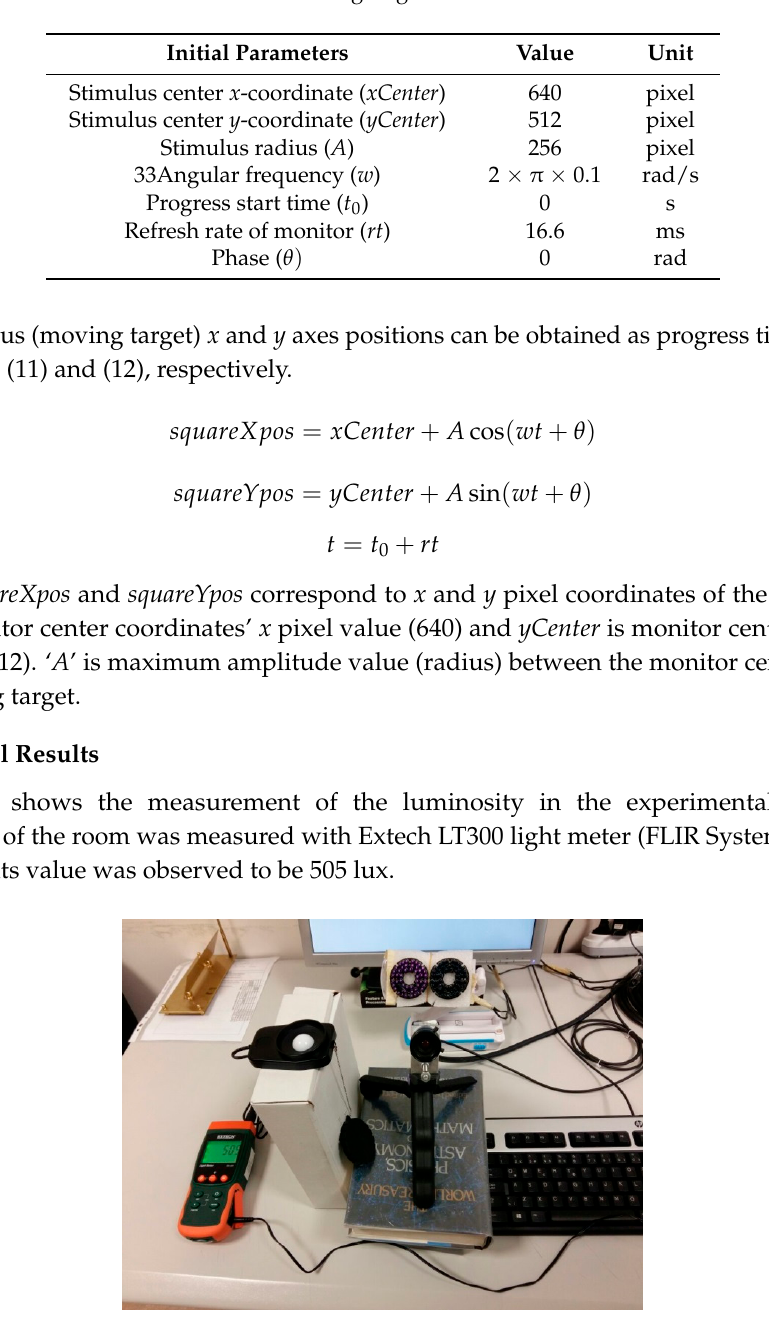
Figure 10. The luminosity measurement of the experimental environment.